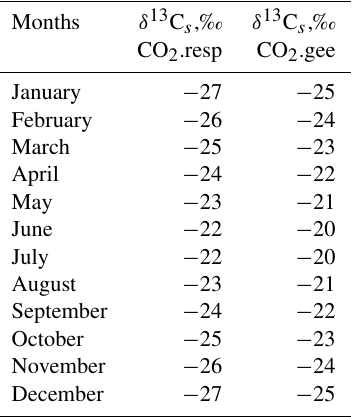
Table 3. Assumptions for ecosystem δ 13 C s based on Ballantyne et al. (2010, 2011) and Vardag et al.